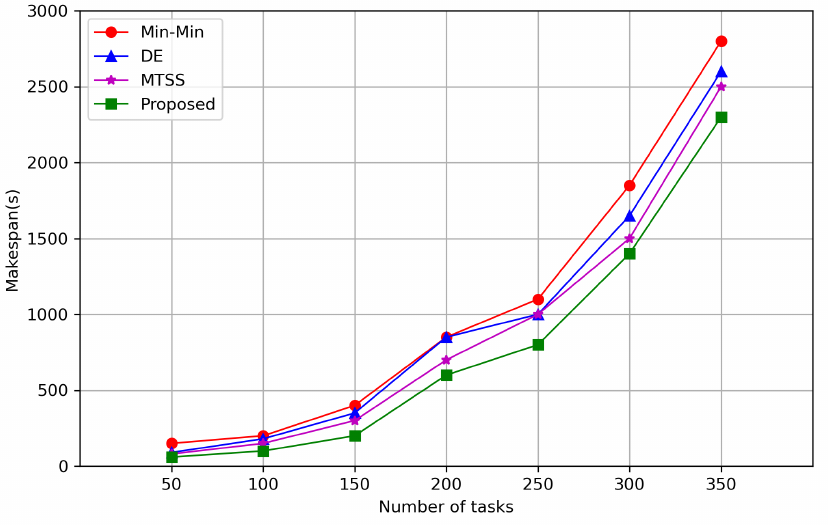
Figure 16. Performance evaluation by using task completion time with the number of